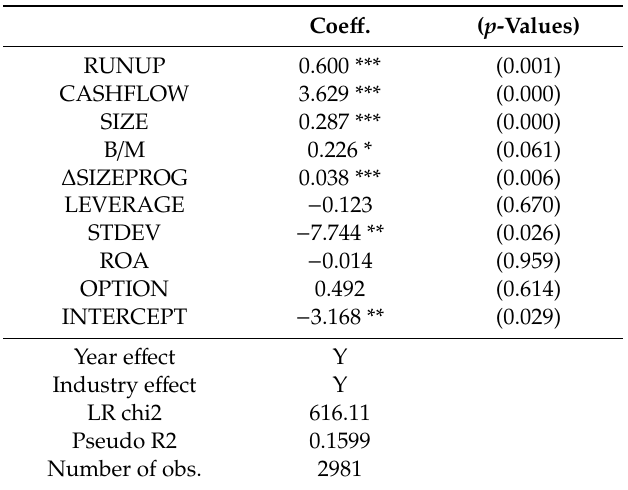
Table 6. The determinants of repeat repurchases. Coe ff